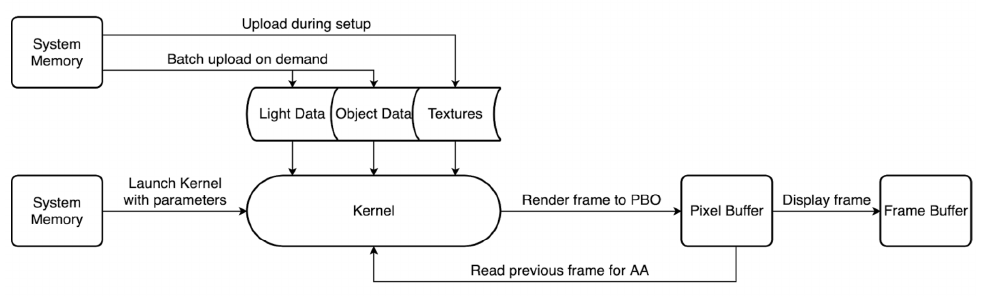
Figure 1. The render pipeline for the proposed engine resides mostly on the graphics card, eliminating one of the bottlenecks due to data transfer and API calls from host to device. Light and object are stored in vectors on the host and copied once per frame to device memory. Textures are uploaded into VRAM and exposed using a texture object